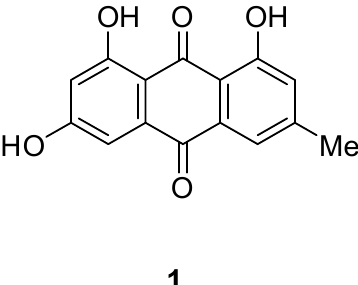
Table 2. Antibacterial activity of compounds 1 and 2 .